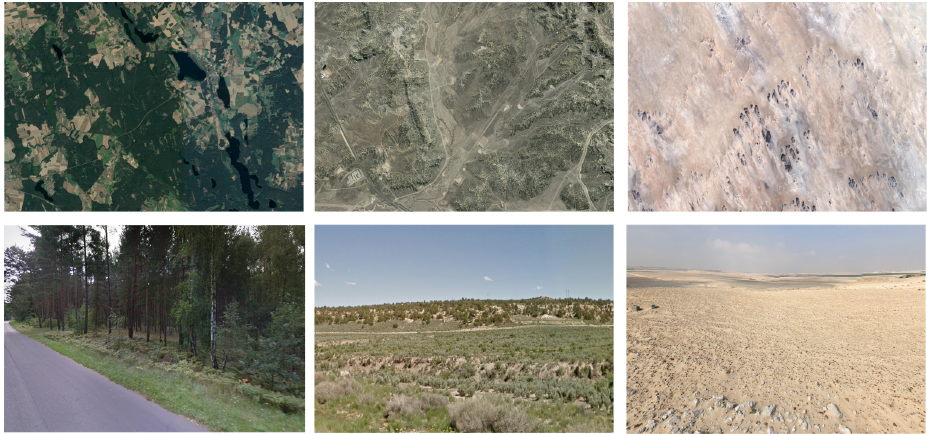
Figure 18. Photographs of the terrains (digital Earth and real) used during the camouflage analysis: forest terrain, steppe terrain, and desert